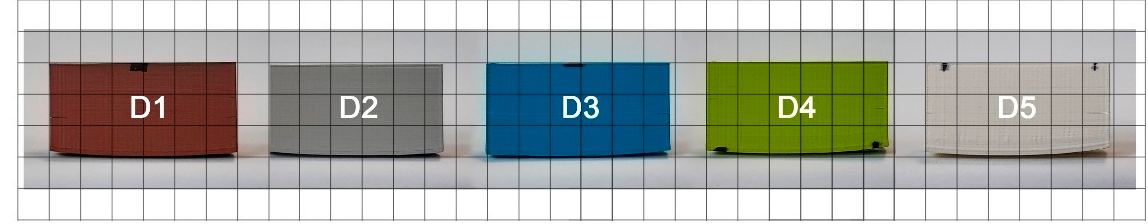
Figure 8. Photos of printed cubes for group D, placed on a 1 × 1 cm 2 grid.